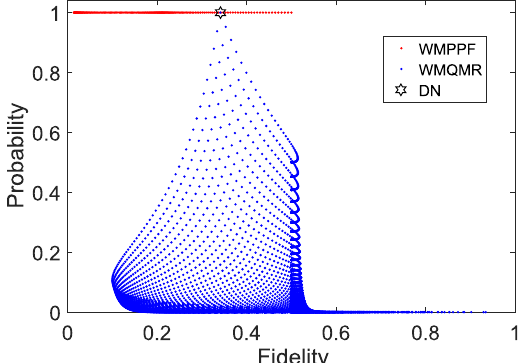
Figure 4. Average fidelity vs. probability with N = 10, θ = π /2, r = 0.3. (1) Fid WMPPF vs. P WMPPF with red dot, the top red line indicate the probability 1. (2) Fid WMQMR vs. P WMQMR with blue dot while p 1 and p r can be any value of the range [0, 1] . (3) Fid DN in this condition only has a value and P DN = 1, which we plot a hexagram to indicate. And for WMQMR, the top blue point in the heart of the hexagram, which indicates that the top blue point is actually the DN case (i.e., p 1 = p r = 0) and its probability is 1. WMPPF can get better average fidelity than WMQMR when WMQMR has large probability (i.e., near 1).